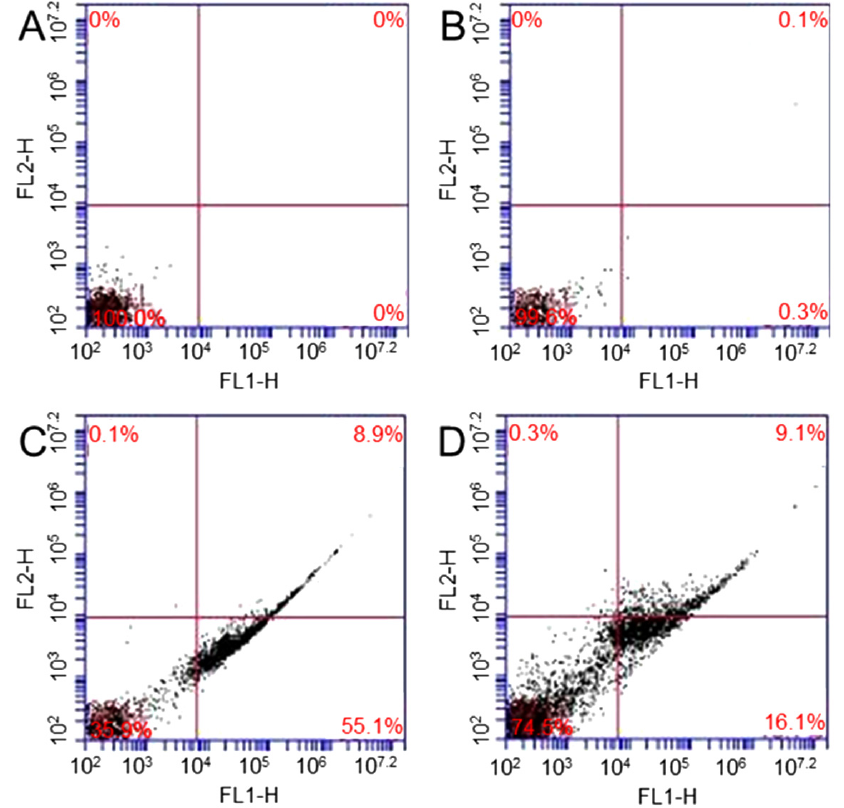
Figure 5. Flow cytometry evaluation of cell apoptosis: cells ( A ); cells treated with GO ( B ); cells exposed to 1.25 Gy X-ray ( C ); and cells treated with 10 µg/mL GO and then exposed to 1.25 Gy X-ray ( D